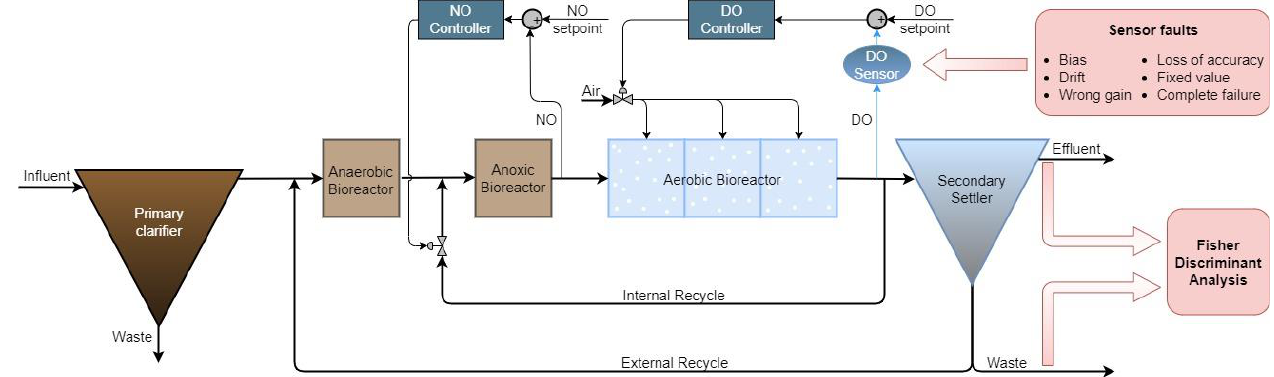
Figure 1. WWTP general structure.